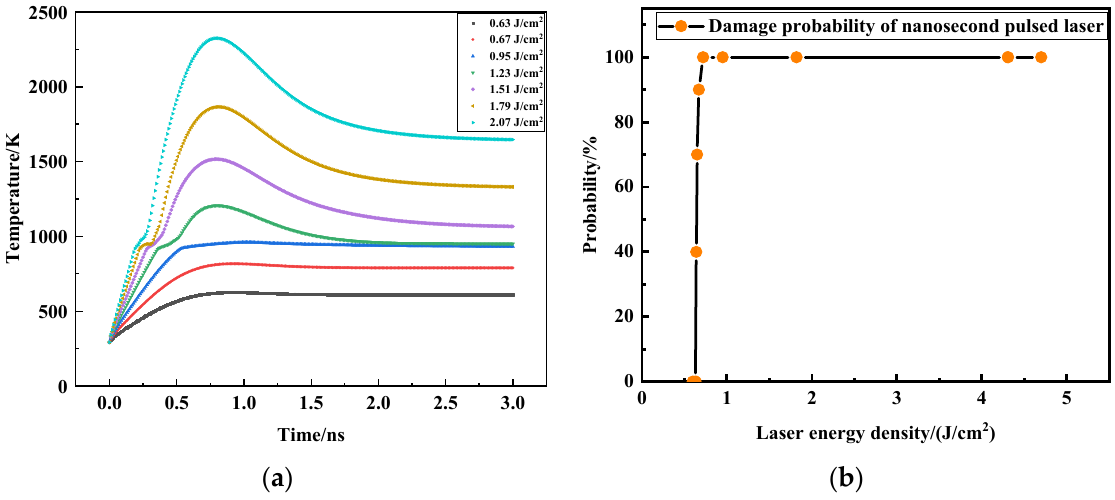
Figure 9. Comparison of LIDT between experimental and simulated data: ( a ) Evolution of temper- ature with time for different laser energy densities, ( b ) The damage probability curve for ACGs under different laser fluence.